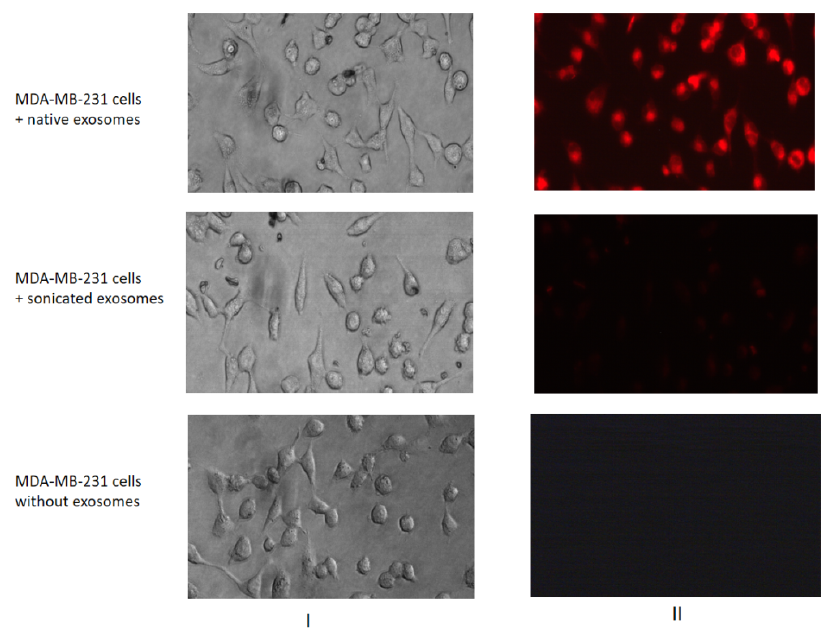
Figure 4. Transferring of fluorescent-labelled compounds by exosomes. MDA-MB-231 cells were cultured without labelled exosomes or with the native or sonicated MCF7 exosomes stained by a fluorescent dye. The efficiency of dyeing exosome incorporation was checked with a fluorescent microscope Nikon Eclipse Ti-E. The images of light (I) and fluorescent (II) microscopy are presented.